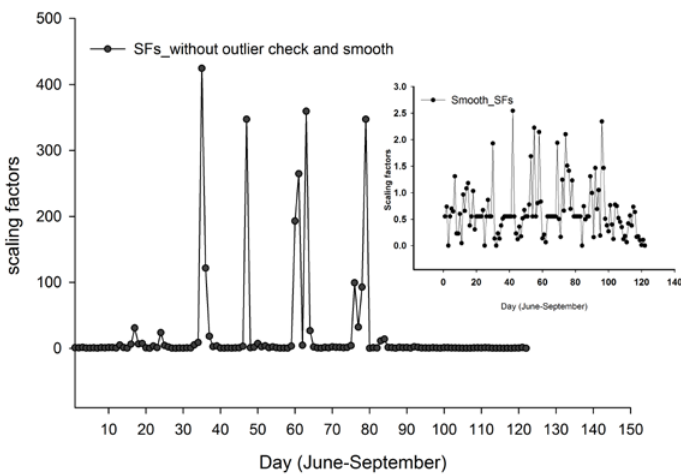
Figure 3. Scaling factors calculated for June to September at Astor climate station with (small plot) and without (large plot) outlier check and smoothed with low pass filter, for the period of 1971–1986.